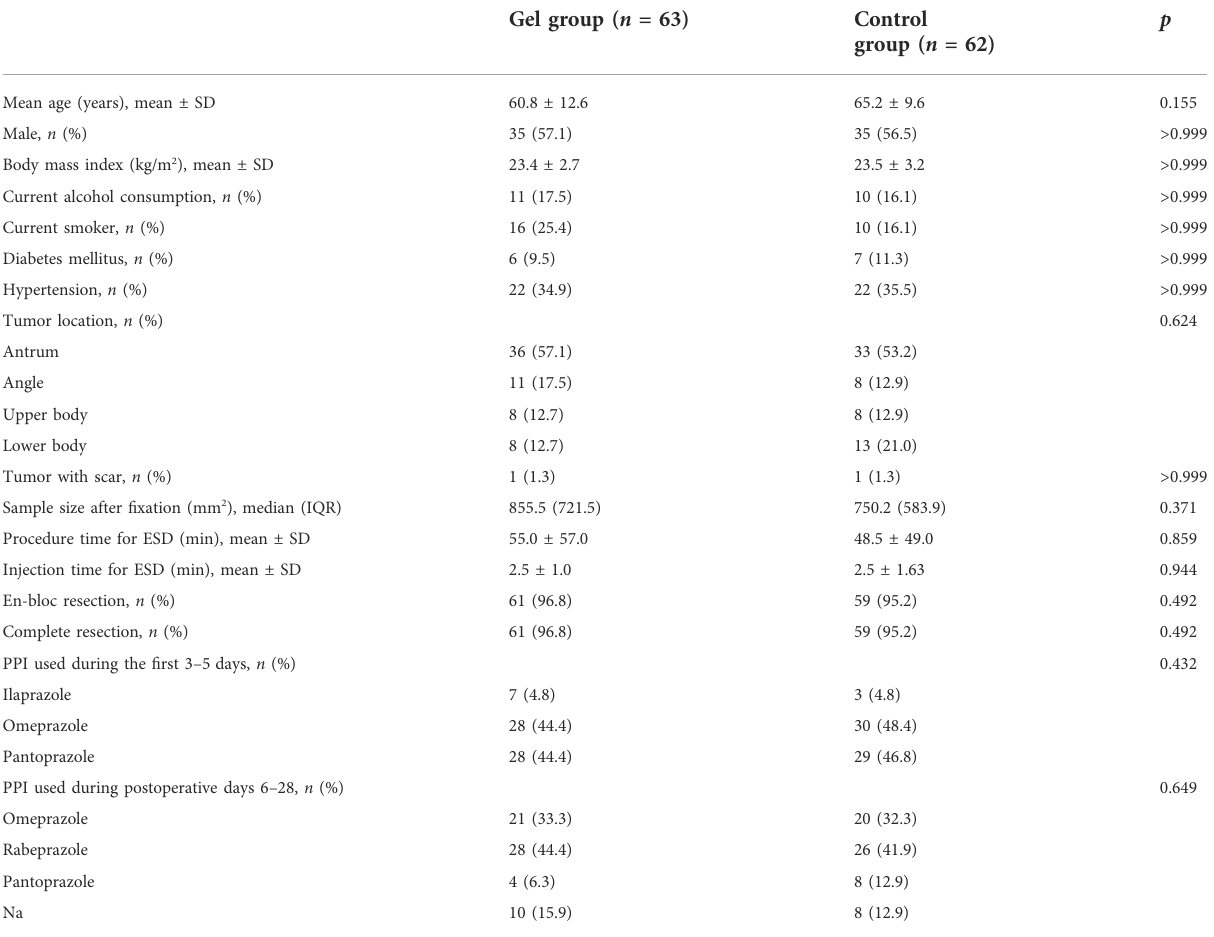
TABLE 1 Baseline characteristics of the study